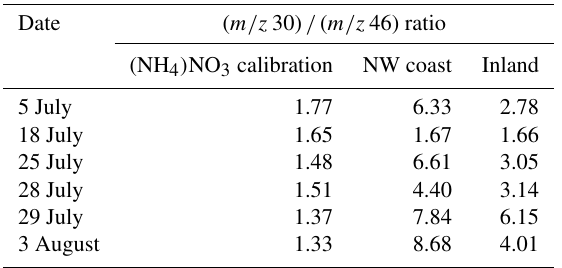
Table 4. Comparison of the m/z 30 / 46 ratios measured in the AMS aboard the